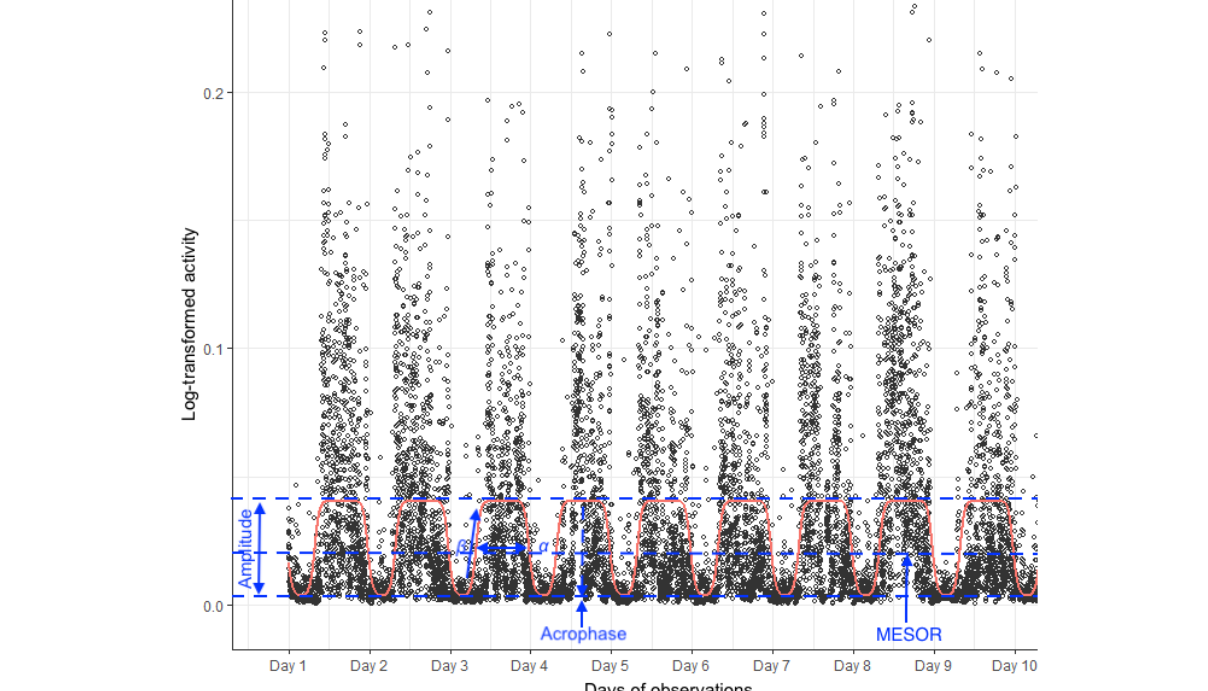
Figure 1. Example of rest-activity rhythm parameters derived from the extended cosinor model. The midline estimating statistic of rhythm (MESOR) is a mean of the modeled activity curve; amplitude is the difference between the peak and trough of the fitted curve, herein estimating the range of activity levels across the 24-hour period; acrophase is a phase marker indicating the time when the fitted curve reaches its peak (ie, time of maximal activity levels across the 24-hour period); α is the relative width of the curve at the middle of the peak; β is an indicator of the steepness of the rise and fall of the curve; and circadian rhythmicity index (F statistic) is an indicator of the strength of circadian rhythmicity (a goodness-of-fit measure for which higher values indicate smaller discrepancies between actigraphy data and values predicted by the cosinor